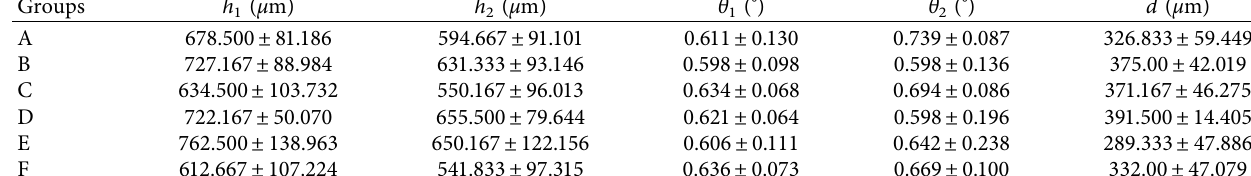
Table 3: Mean trueness standard deviation (SD) of crown-and bridge models of resins having different values. Groups ±